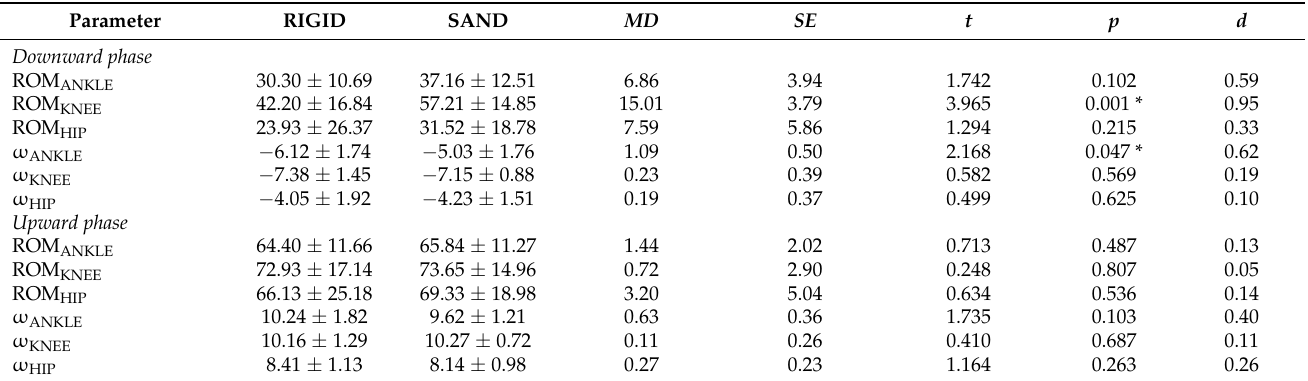
Table 3. Means ± standard deviations of the comparison for the joint kinematic parameters of the drop jumps on RIGID and SAND surface ( n =